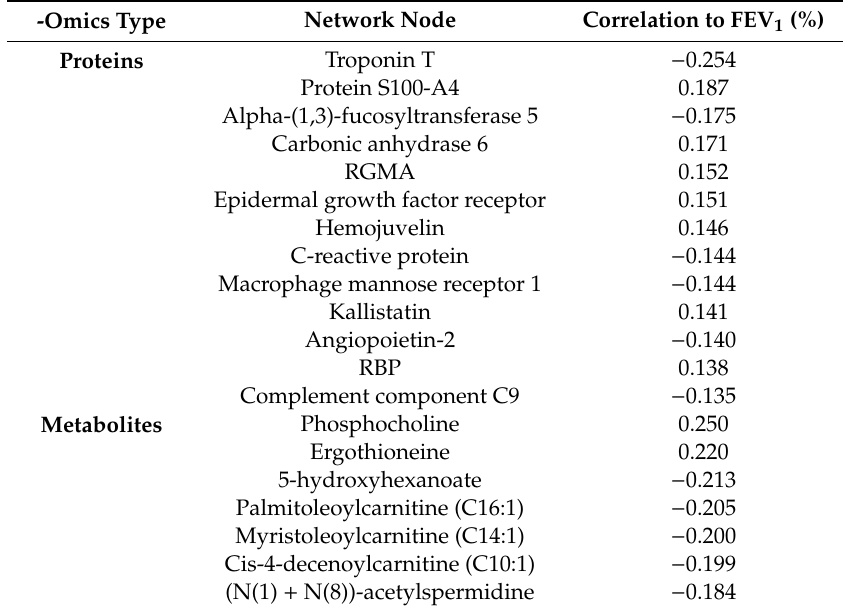
Table 2. Individual network node correlations to FEV 1